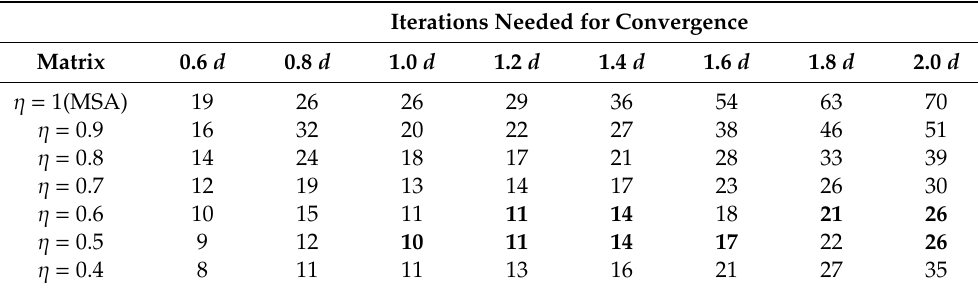
Table 9. Results on the rural real-scale